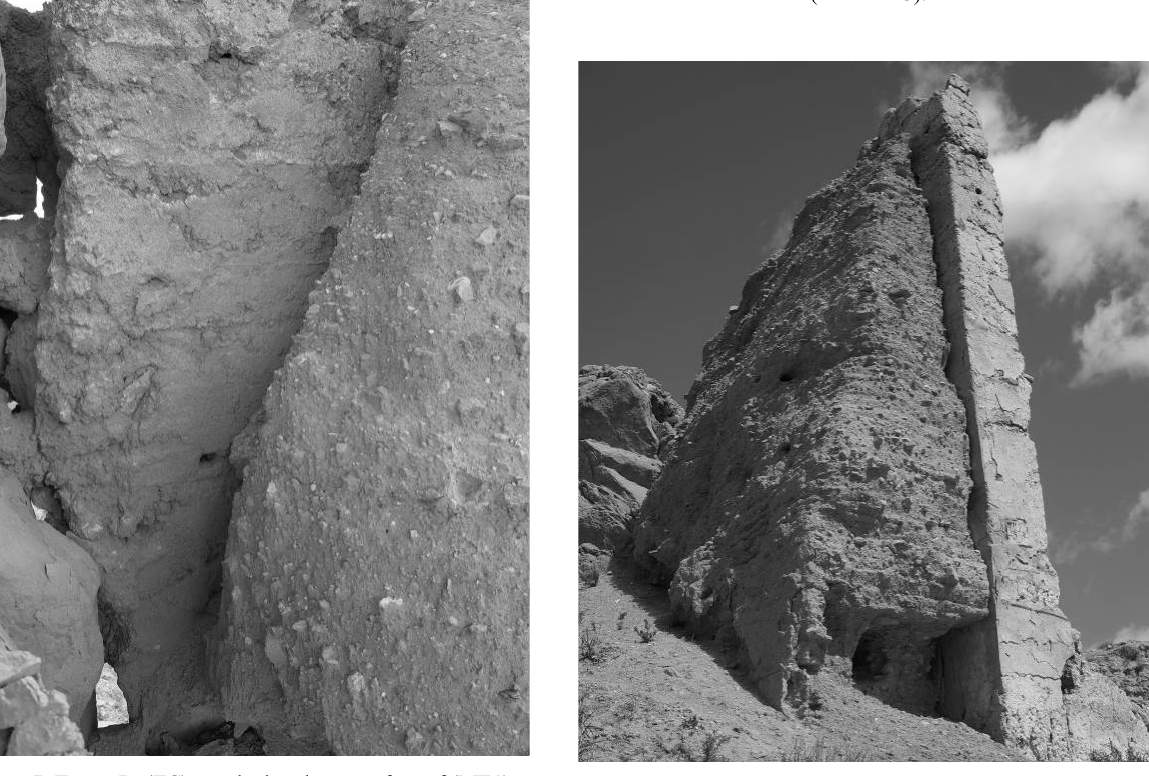
Figure 9. Tower B. (TC) attached to